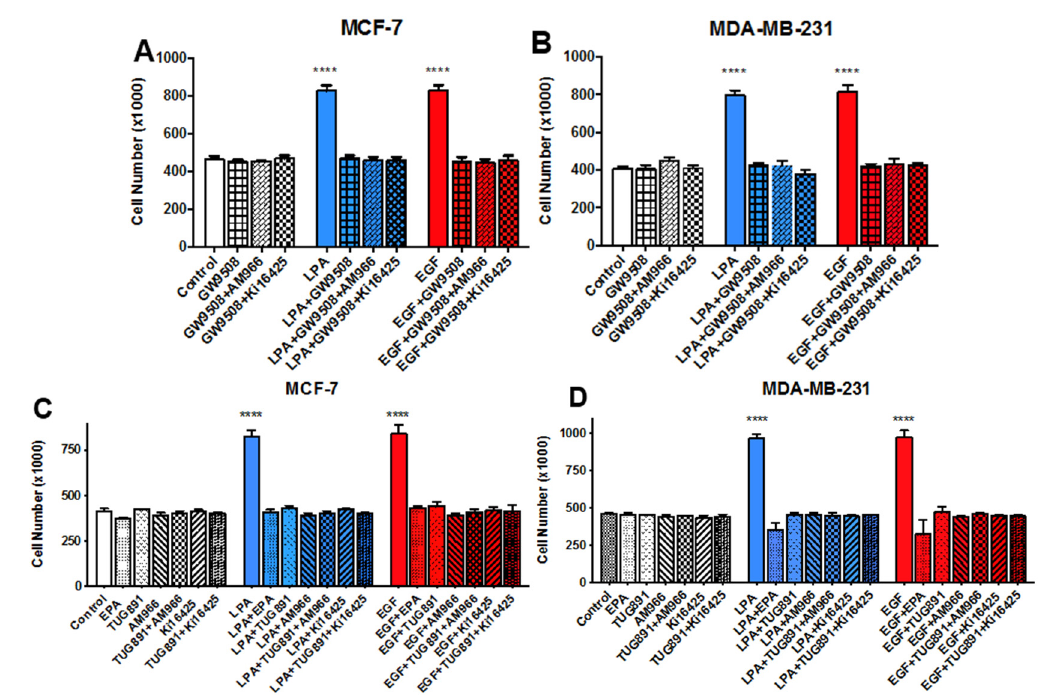
Figure 7. Effects of FFAR agonists on breast cancer cell proliferation. Serum ‐ starved MCF ‐ 7 or MDA ‐ MB ‐ 231 cells were incubated with or without 10 μ M LPA or 10 nM EGF for 48 h in the absence and presence of 1 μ M GW9508, 10 μ M Ki16425, and/or 10 μ M AM966 (Panels A and B ), or (Panels C and